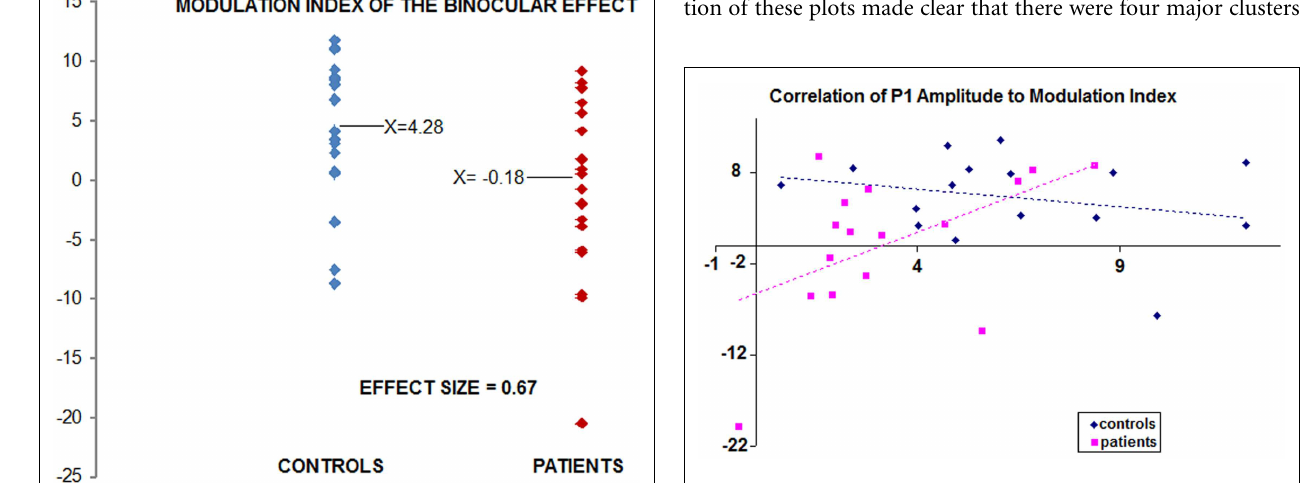
FIGURE 2 | Modulation index for the binocular effect: each point in the scatter plot represents the data for one participant .Values were derived by subtracting Binocular (BASE) from SUM conditions. Controls are shown in blue, patients in red. Using Cohen’s d , the effect size of the difference is 0.67.